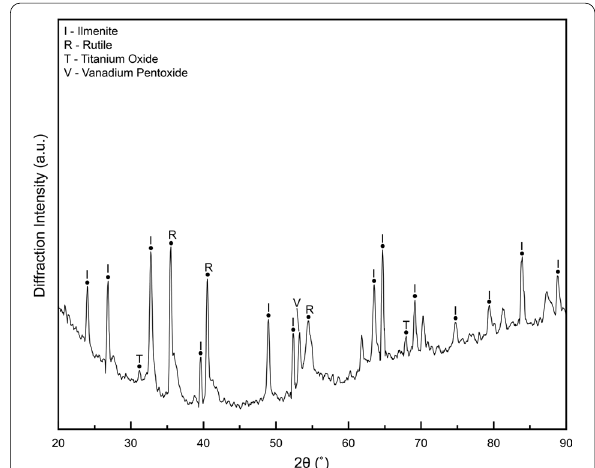
Fig. 3 X-ray diffractogram of initial ilmenite sample. Where, V: vanadium pentoxide (V 2 O 5 ), I: ilmenite (FeTiO 3 ), R: rutile (TiO 2